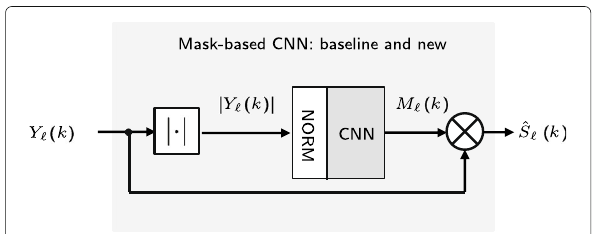
Fig. 1 Schematic of the mask-based CNN for speech spectrum enhancement, used for both the baseline CNN (baseline losses) and the new CNN (components loss). Details of the CNN can be seen in Fig.